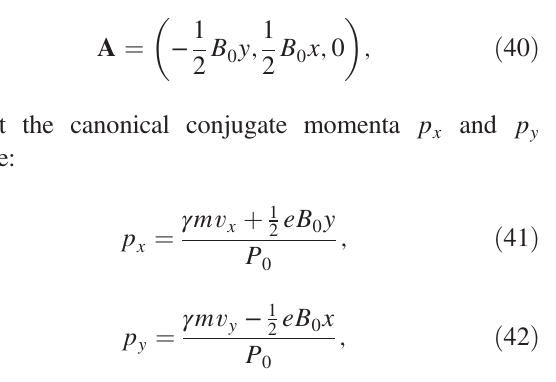
FIG. 10. Normalized normal mode emittances as a function of current in the bucking coil at the electron source, with fixed bunch charge and main solenoid current. The markers on solid lines show experimental (measured) values determined from four-dimensional phase space tomography (as described in Sec. III C), the dashed lines show values from GPT simulations, and the dotted lines show values from a simple theoretical model. The upper and lower sets of lines (blue and red, respectively) show the normalized normal mode emittances; the middle set of lines (black) show the geometric mean of the emittances. Parameters in the simulations and theoretical model are chosen to fit the experimental